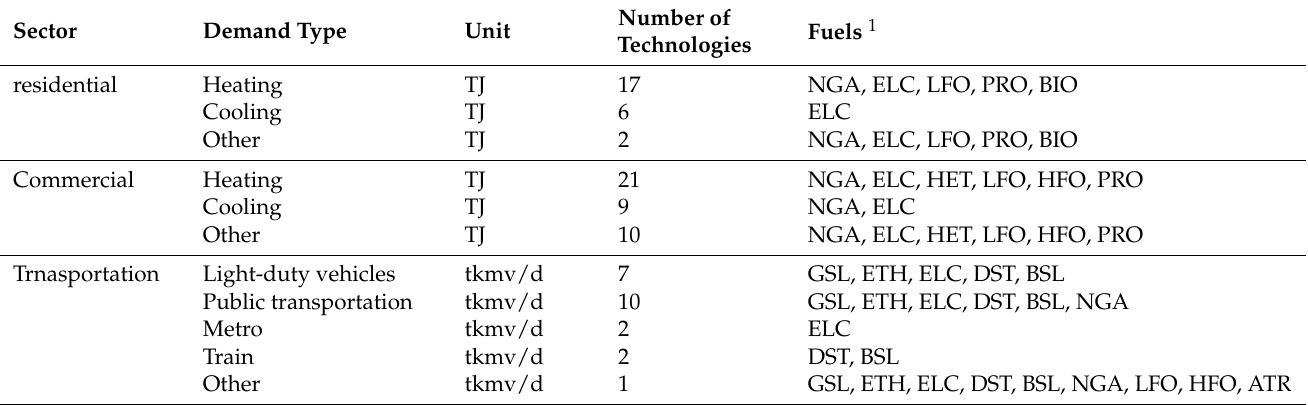
Table A1. Useful demand